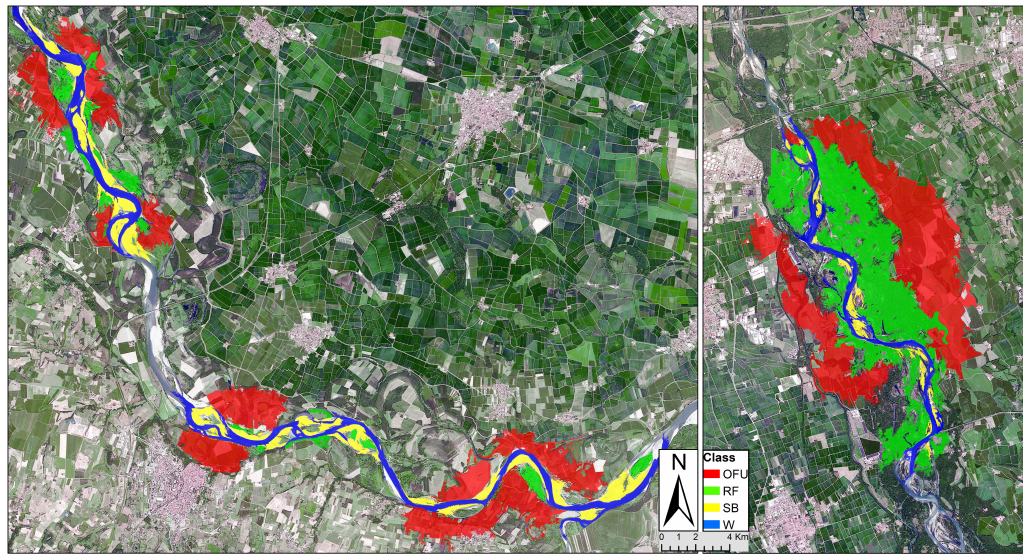
Figure 8. Example of reference samples collection with random spatial